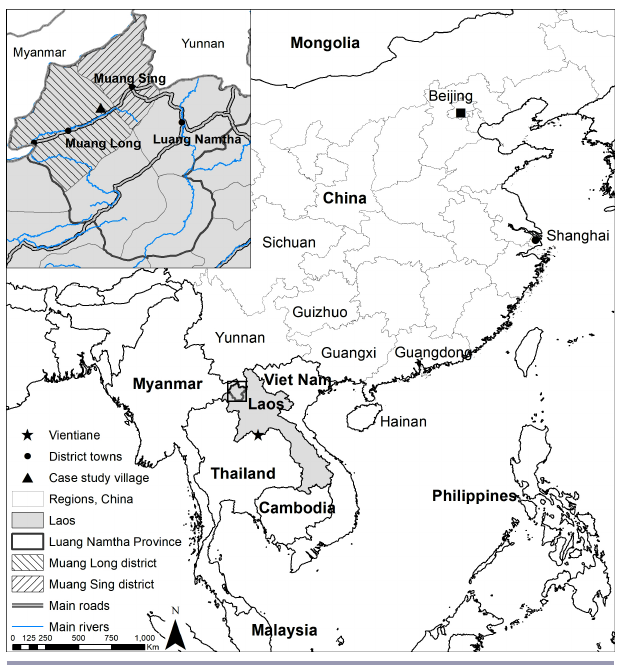
Fig. 1. Map of the study area and the main sites linked to banana plantations in Luang Namtha Province, Lao